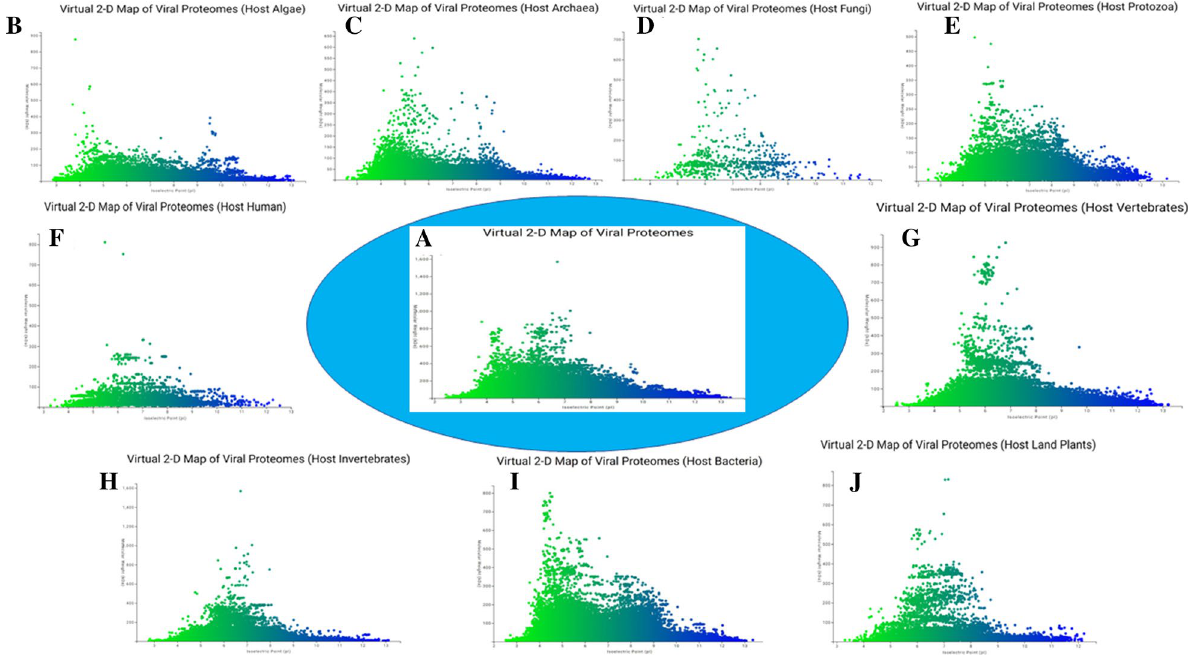
Figure 6. Virtual 2D map of virus proteome. ( A ) The molecular weight and isoelectric point of the virus proteome showed a bimodal distribution. Host-dependent modal distribution of virus proteome can be seen from the figure. Few encode unimodal [( D ) fungi, ( F ) human, ( H ) invertebrate, ( J ) plants, ( E ) protozoa, and ( G ) vertebrate], a few bimodal [( B ) algae, ( C ) archaea] and ( I ) bacteria showed trimodal distribution of molecular weight and isoelectric point of virus proteome. The colour opacity represents the acidity and alkalinity of the virus proteome. Green hues tend toward acidity, whereas blue hues tend toward alkalinity. The scatter plots were generated using “scatter plot online” server (https:// scatt erplot.